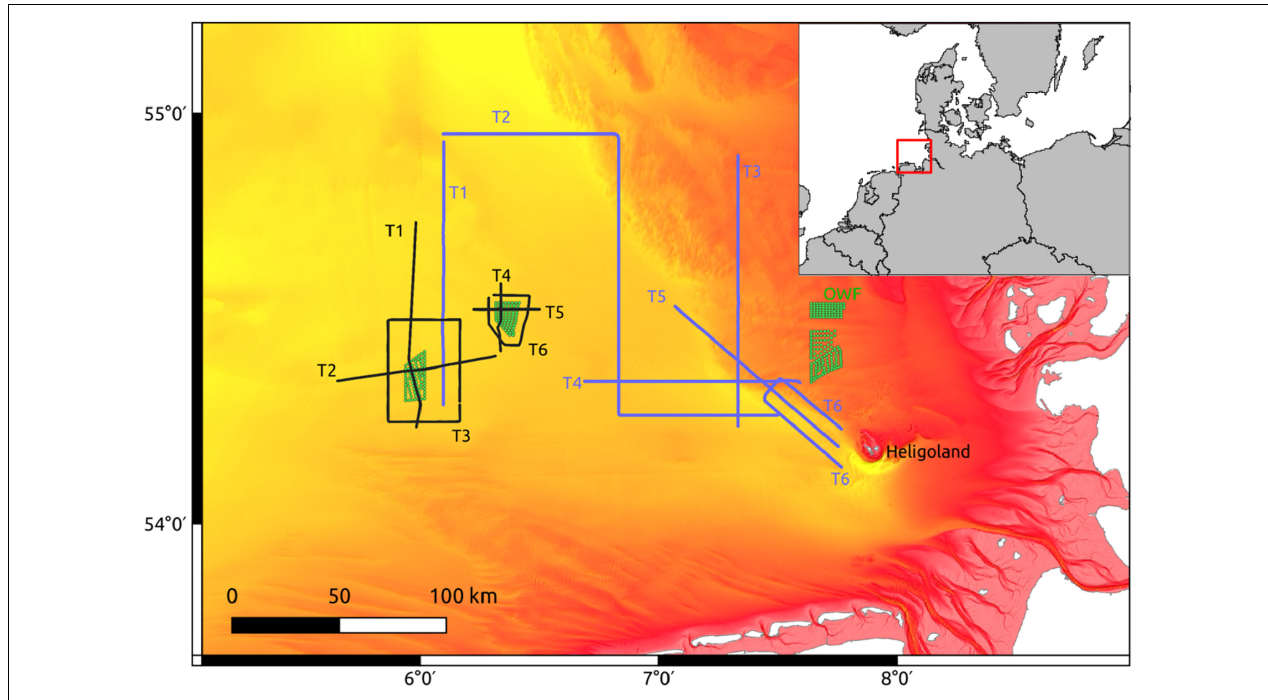
FIGURE 1 | Sampling transects from HE429 (black) and HE534 (blue) in the German Bight of the North Sea. Green dots: Wind turbines. Depth ranges from 10 m (red) to 50 m (yellow). The red box marks the location of the bigger map.